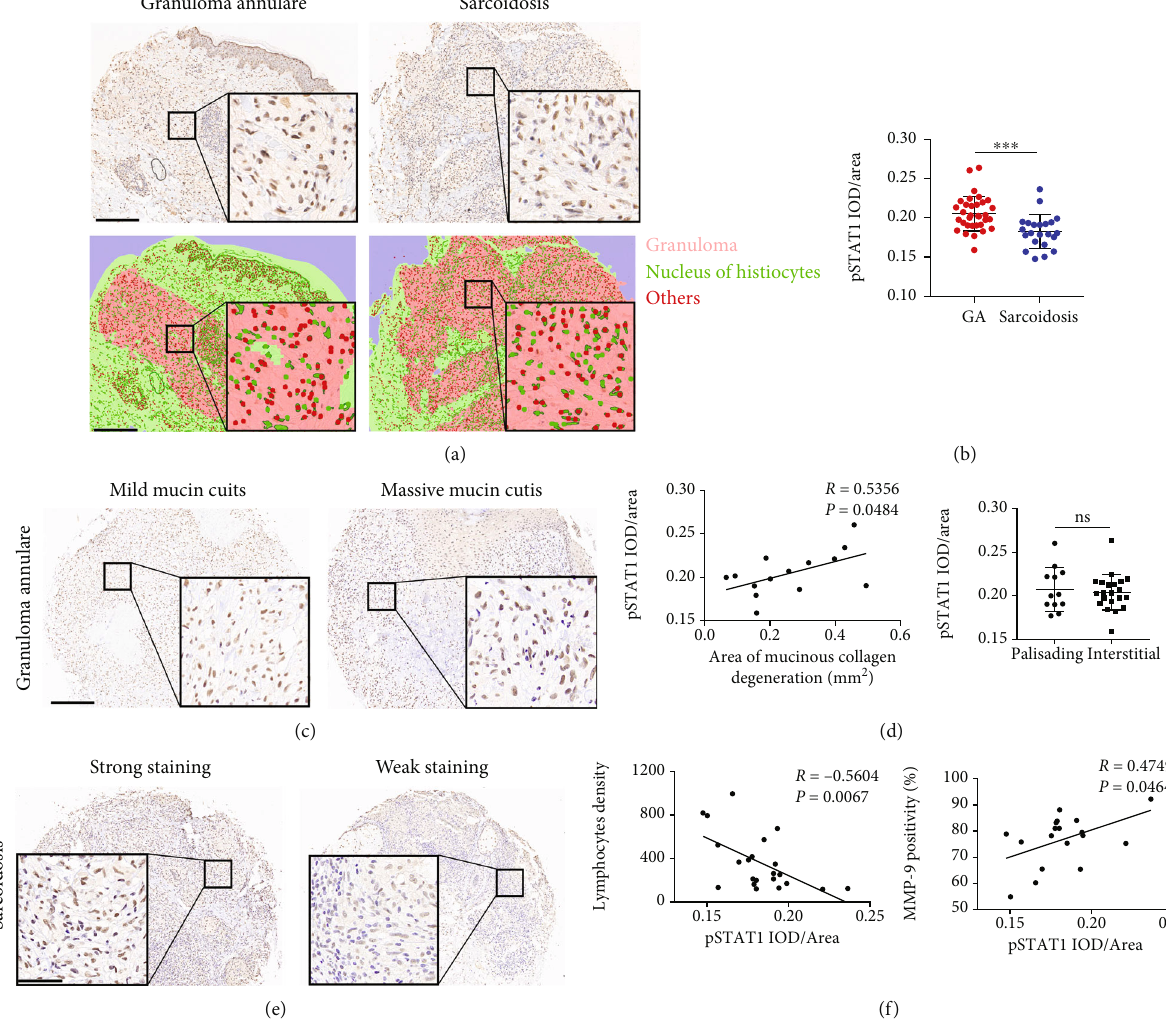
Figure 4: pSTAT1 expression in granuloma annulare and sarcoidosis biopsies. (a) IHC staining (upper row) and segmentation (lower row) in patients with GA (left column) and sarcoidosis (right column), scalebar = 250 μ m . (b) Quanti fi cation of IHC staining for pSTAT1 in patients with GA and sarcoidosis. (c) pSTAT1 IHC in GA patients with mild (left panel) and massive (right panel) mucin cutis and collagen denaturation, scalebar = 250 μ m . (d) Correlation between pSTAT1 expression and area of mucin cutis and collagen denaturation in GA; quanti fi cation of IHC staining for pSTAT1 in palisading and interstitial GA biopsies. (e) pSTAT1 IHC in sarcoidosis patients with pSTAT1 strong (left panel) and weak (right panel) staining, scalebar = 55 μ m . (f) Correlation between pSTAT1 expression and lymphocyte density; correlation between pSTAT1 and MMP-9 expression in